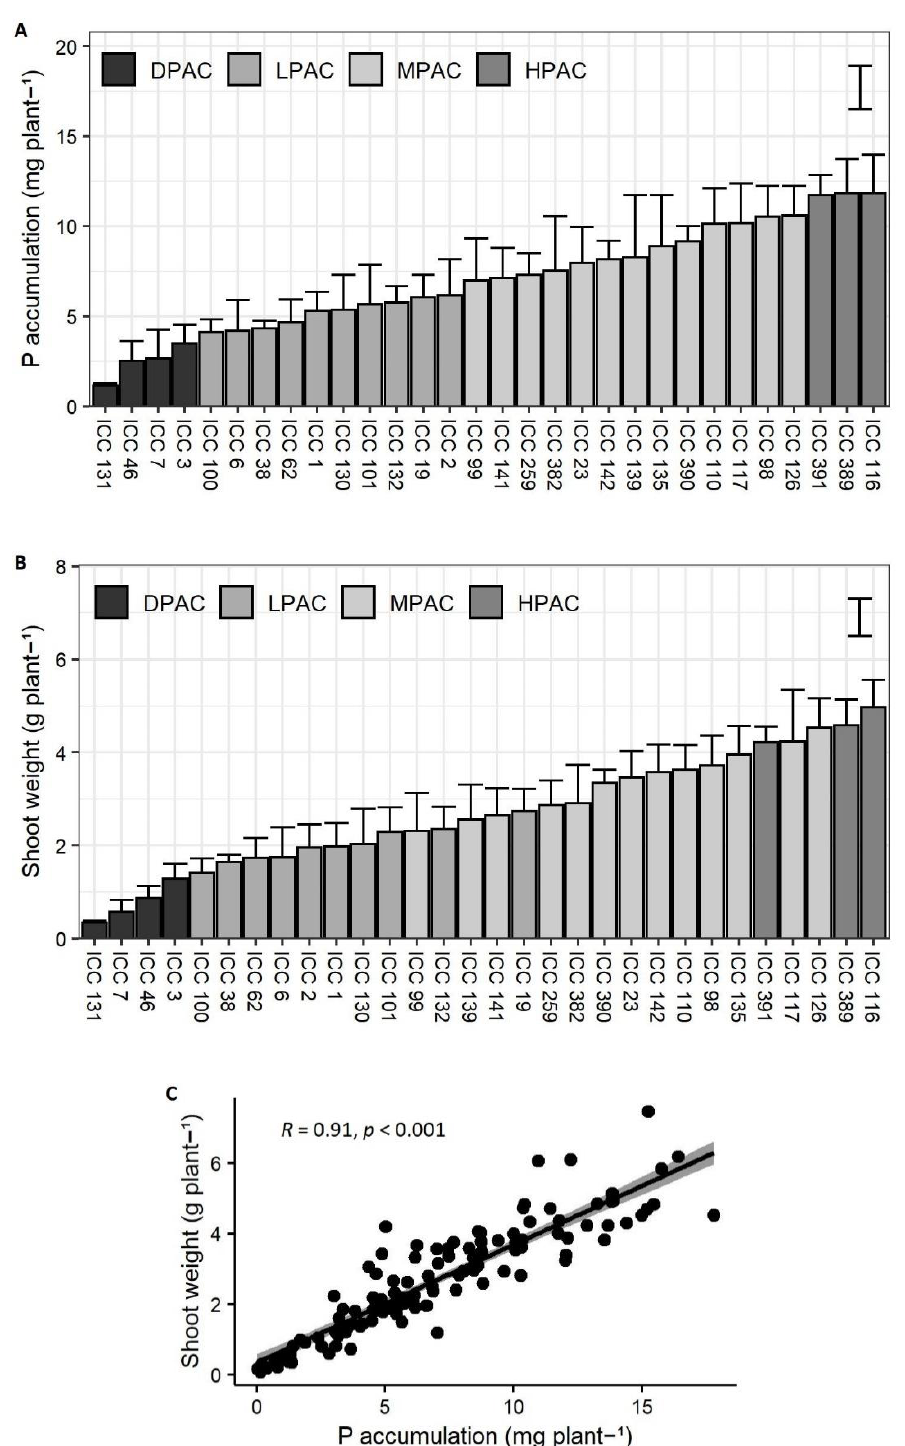
Figure 1. Growth and P accumulation of thirty Chilean quinoa accessions after 13 weeks of plants growing on a volcanic soil with low available P. Graphs representing phosphorus accumulation in biomass per plant ( A ), shoot biomass production per plant ( B ), and Pearson correlation analysis among both variables ( C ). Error bars result from the mean of four biological replicates ( ± SE). Bars in ( A , B ) represent least significant difference (LSD) at p = 0.05 among genotypes. Abbreviations: high P acquisition capacity (HPAC), medium P acquisition capacity (MPAC), low P acquisition capacity (LPAC), and deficient P acquisition capacity (DPAC).